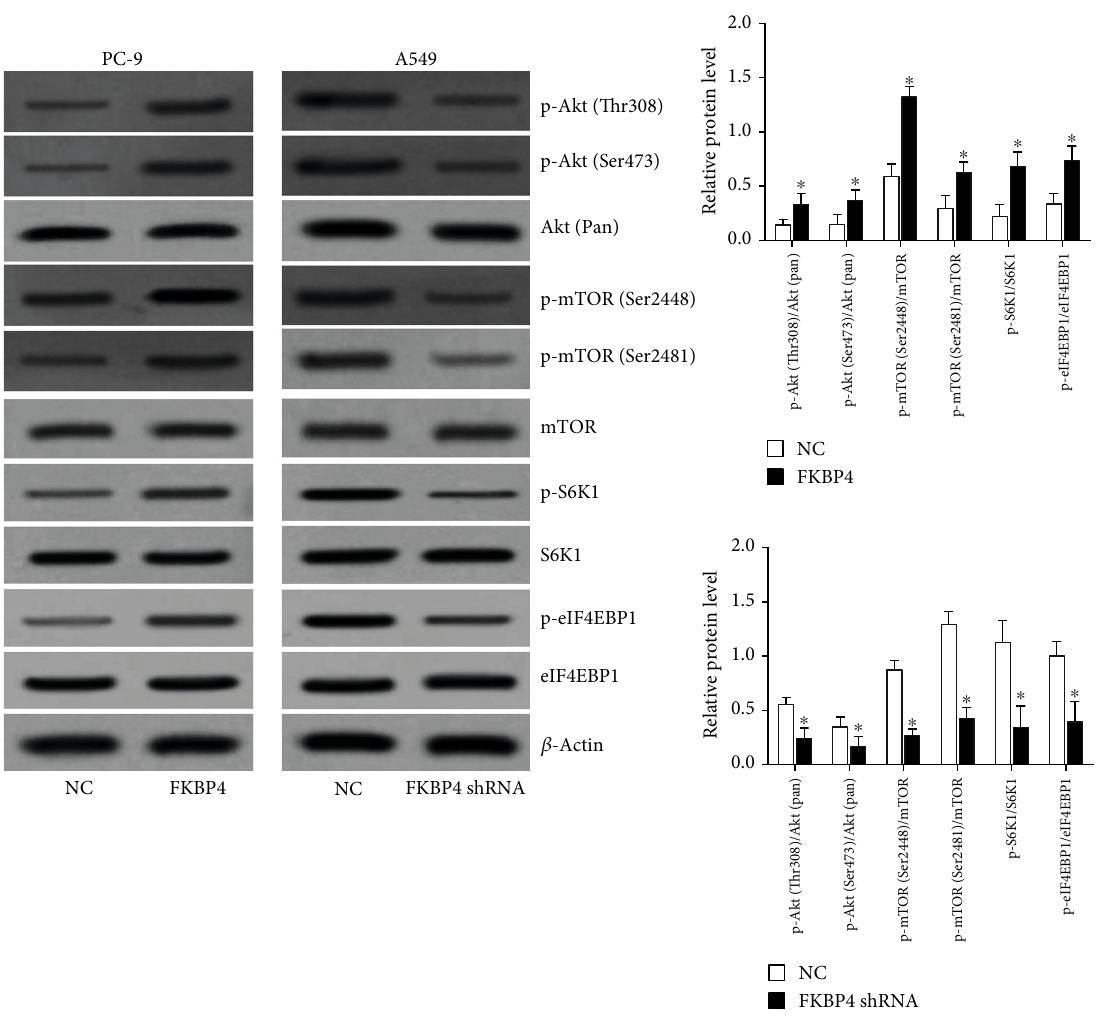
Figure 10: FKBP4 activates the Akt/mTOR signaling pathway in NSCLC cells; N = 3 , ∗ P < 0 : 05